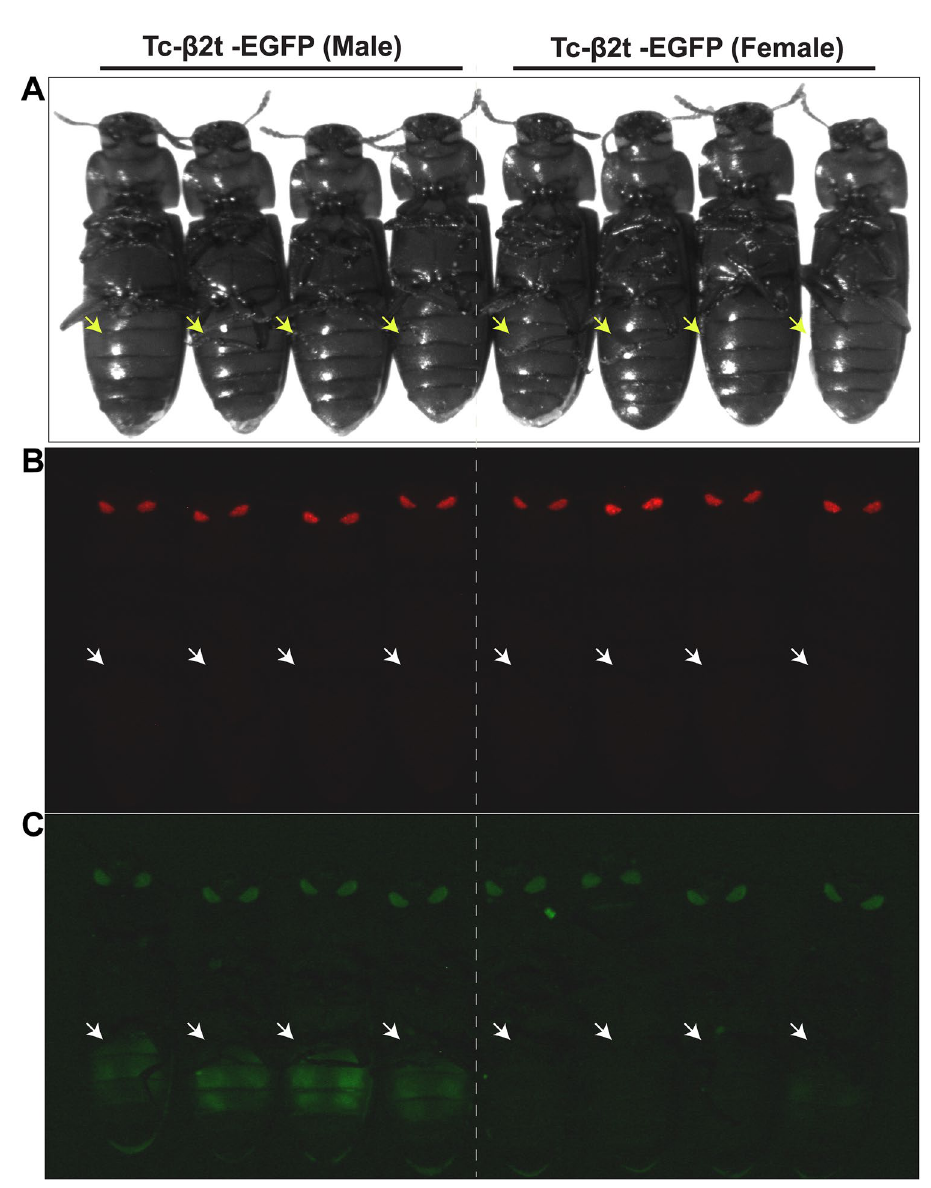
Figure 3. Fluorescent microphotographs showing sex-specific β2t drive EGFP expression in T. castaneum . ( A ) Transgenic adult male and female beetles viewed under bright field ( B ) DsRED filter and ( C ) GFP filter. Arrows indicate the abdomen where EGFP expression respectively was expected for transgenic male beetles in Tc-β 2 t- EGFP lines in gfp